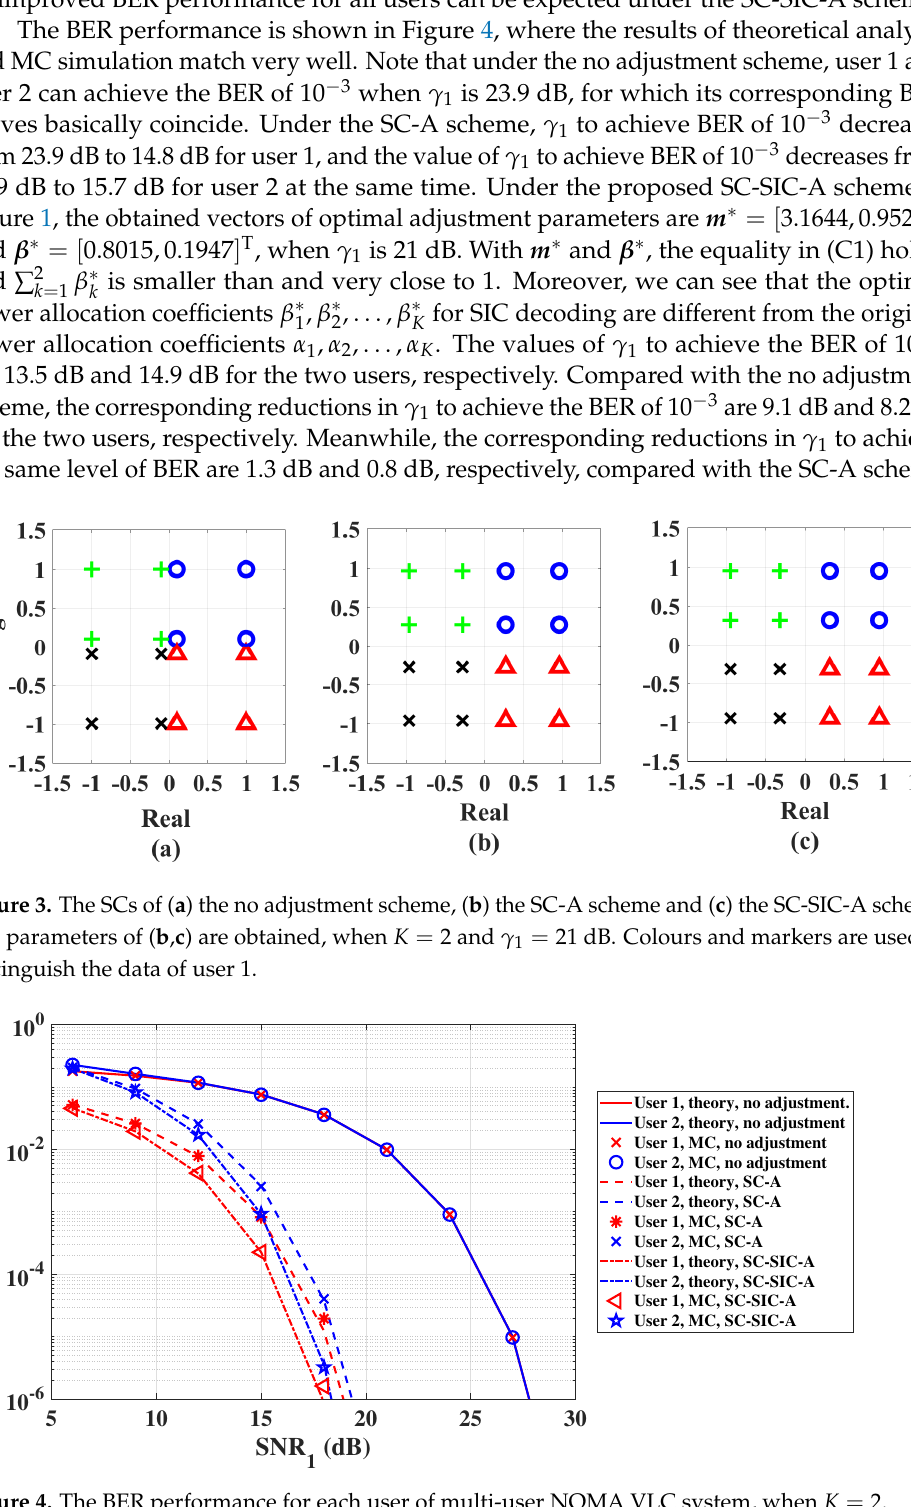
Figure 4. The BER performance for each user of multi-user NOMA VLC system, when K =